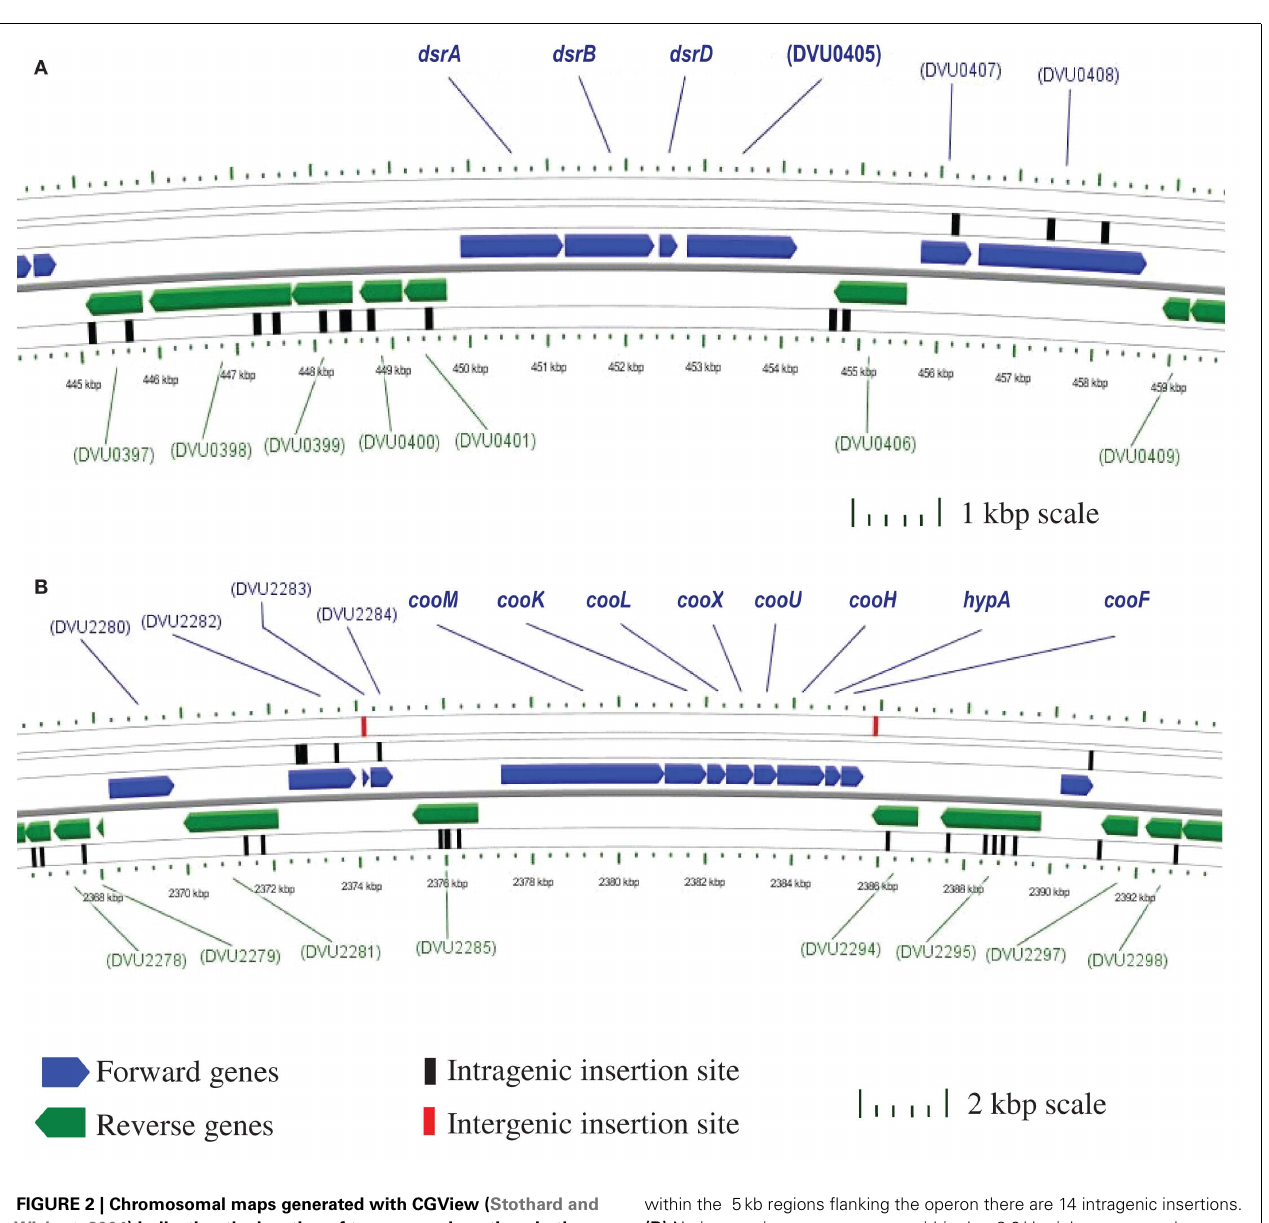
FIGURE 2 | Chromosomal maps generated with CGView (Stothard and Wishart, 2004) indicating the location of transposon insertions in the Desulfovibrio vulgaris Hildenborough genome. Open reading frames are designated byTIGR DVU numbers. (A) No intragenic transposons are within the 4.2kb four gene dissimilatory bisulfite reductase ( dsr ) operon; however